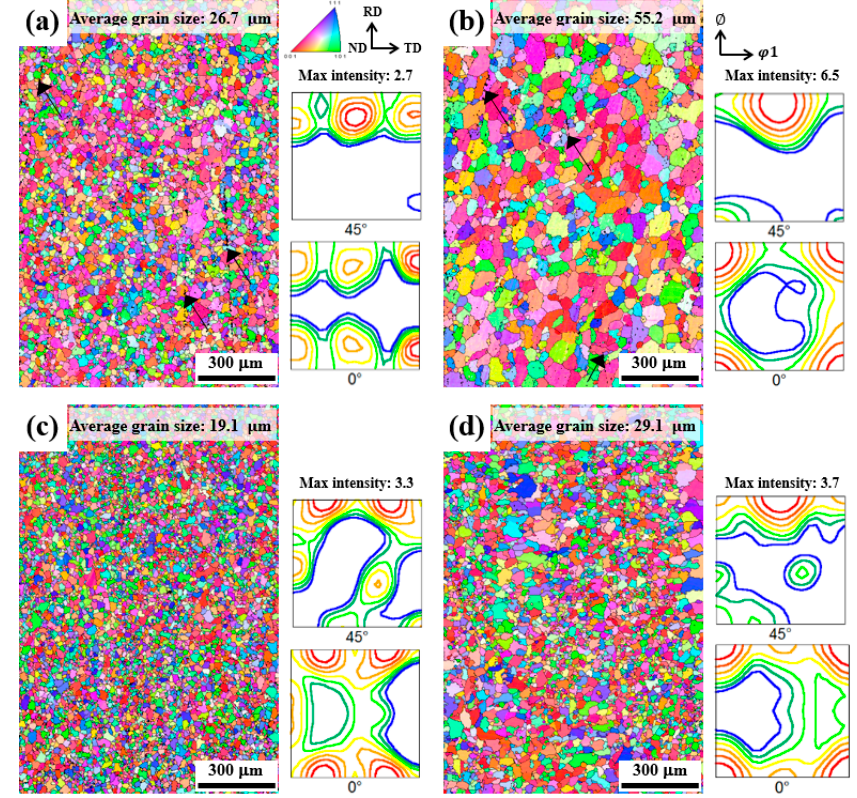
Figure 6. IPF maps and ODFs in the ( a ) NH, ( b ) NL, ( c ) RH, and ( d ) RL sheets recrystallized at 540 °C for 30 min. The microscale particles of the NH and NL sheets are crushed and aligned parallel to the RD, as indicated by the black arrows.